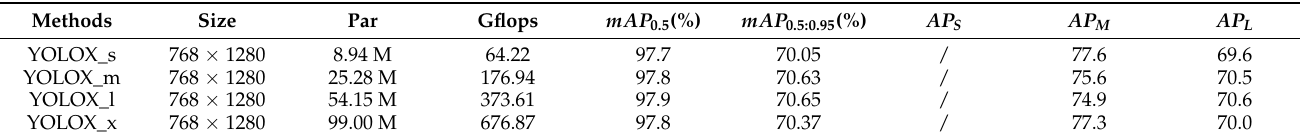
Table 2. Different versions of YOLOX performance